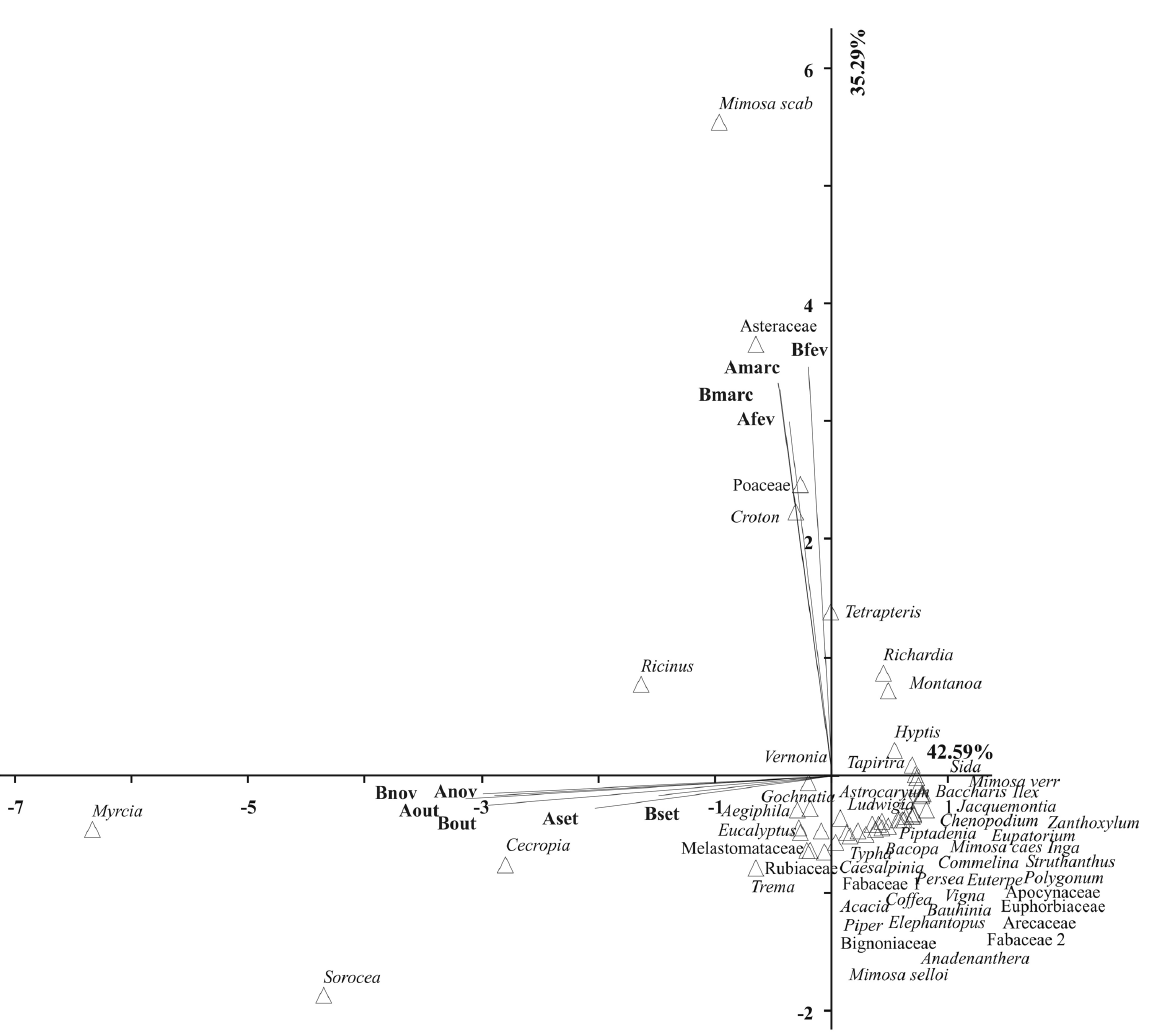
Fig. 1 – PCA biplot for pollen types in pollen pellets samples per month from Pará de Minas, Minas Gerais State, using the absolute value of the variables per